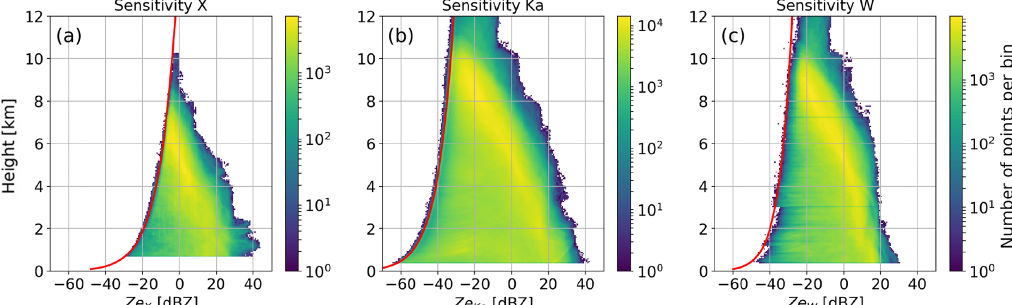
Figure 8. Histograms of reflectivities from the entire TRIPEx campaign Level 2 data for each radar. The red curve is the profile of the minimum retrieved reflectivity (Eq. 2). Panels (a) , (b) , and (c) show the histograms for the X, Ka, and W band, respectively; all error flags (see Table 4) were applied to filter the data. Note the log scale on the color bars.